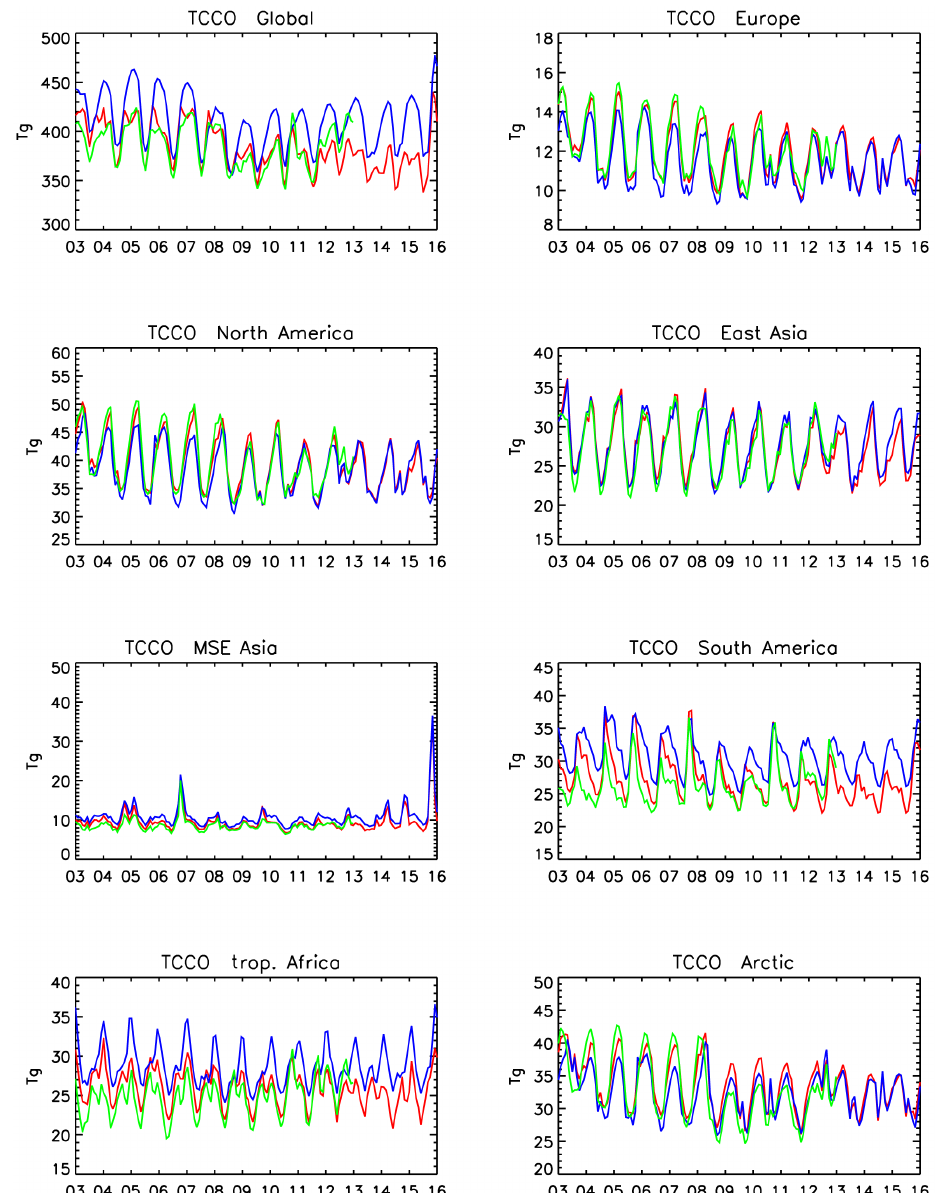
Figure 4. Time series of monthly mean CO burden (Tg) over different regions (see Table 3) for the period 2003–2015 from CAMSiRA (red), the CR (blue) and MACCRA (green,